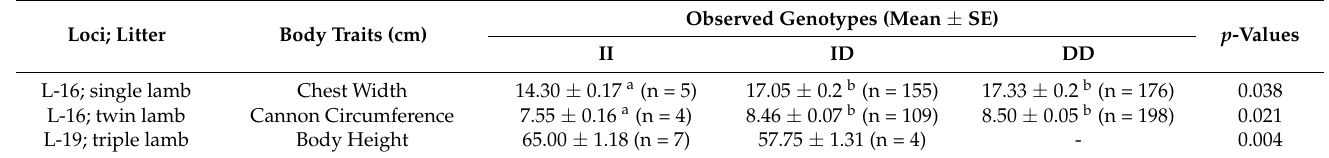
Table 4. Associations of the loci of the CFAP43 gene with body traits in Shaanbei white cashmere goats at different litter sizes (mean ± standard error (se)). Different letters indicate significant differences at p <